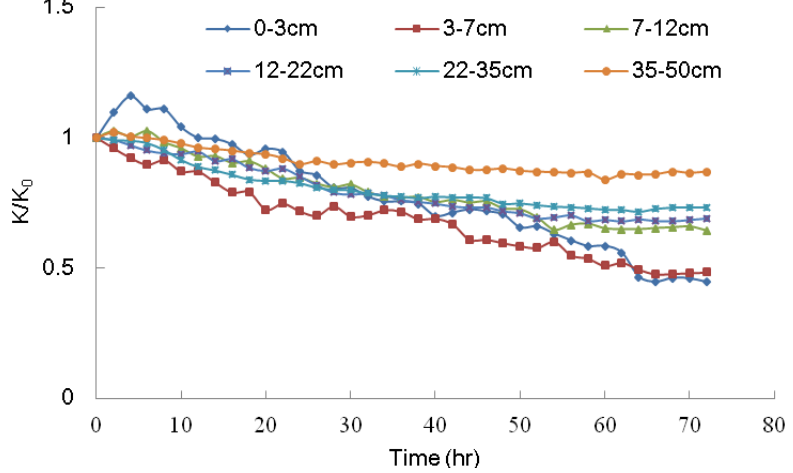
Figure 7. K /K vs. operation time (Exp. No.E2). 0